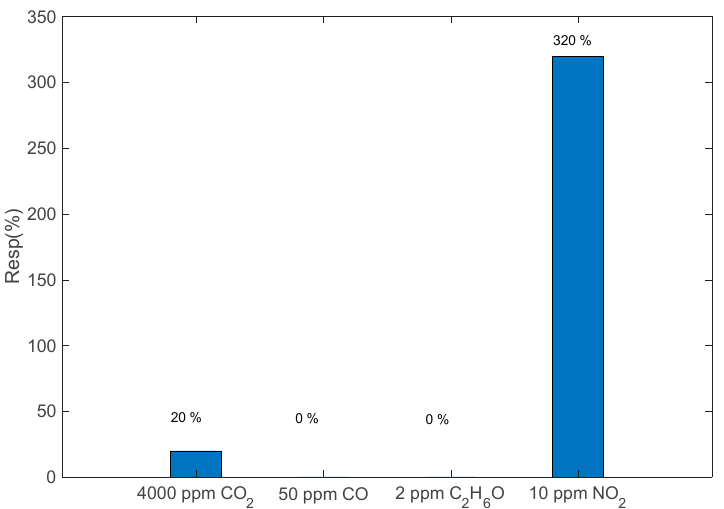
Figure 11. Sensor response to 4000 ppm CO 2 , 50 ppm CO and 2 ppm C 2 H 6 O compared with the response to 10 ppm NO 2 , according to Equation (1); N 2 gas carrier, T ≈ 200 °C. Data evaluated by means of repeated transient gas measurements as for plots in Figures 3 and 4.